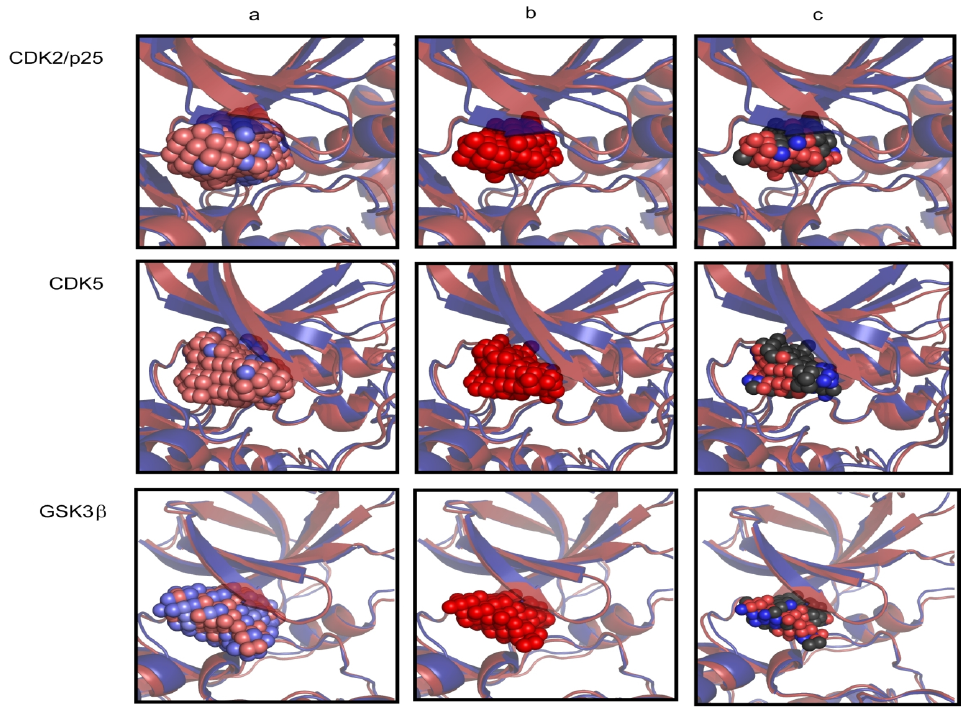
Figure 8. The results of the ASP MD simulation illustrated for CDK5/p25, CDK5 and GSK3 β . Graphic showing the starting protein conformation prior to ASP (blue cartoon model) and the conformation after the insertion of 150 ASP particles (red cartoon model). ( a ) The latent ASP particles coloured from high force (blue spheres) to low force (red spheres); ( b ) The kinase protein conformations after insertion of 150 ASP particles are depicted similarly in red including a depiction of the 150 activated ASP particles (red spheres); ( c ) A depiction of the 150 activated ASP particles coloured according to the nearest heavy atom neighbour of the protein (CPK coloured